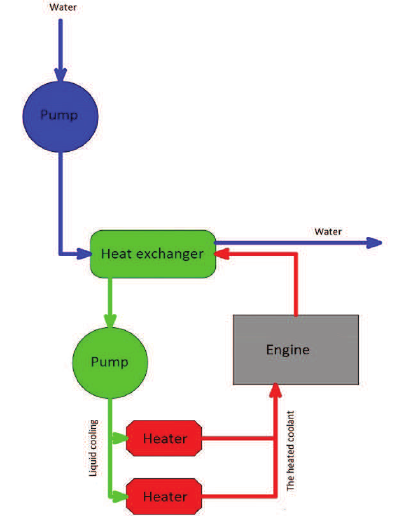
Fig. 10. Diagram of the primary control system of coolant temperature engine on a test bench